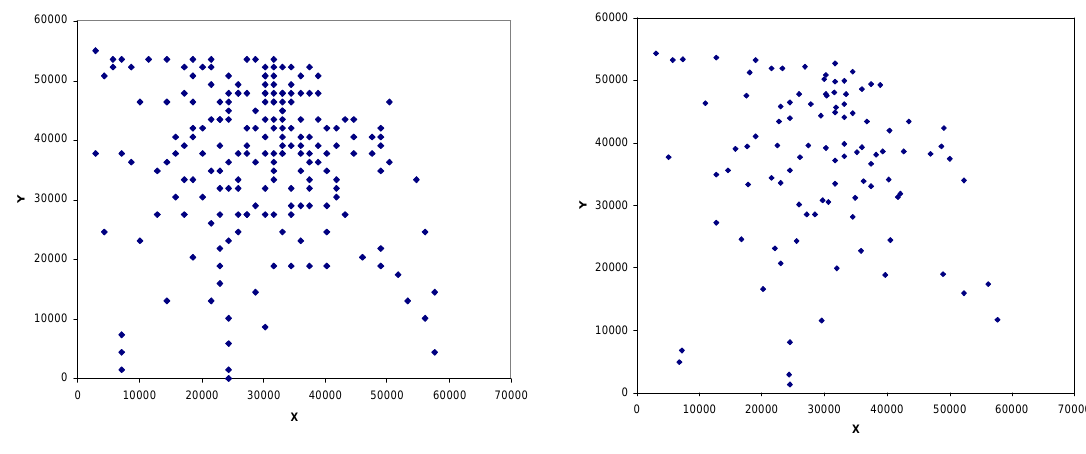
Figure 2. AP data set. Figure 3. AP data set reduced to 100 nodes.